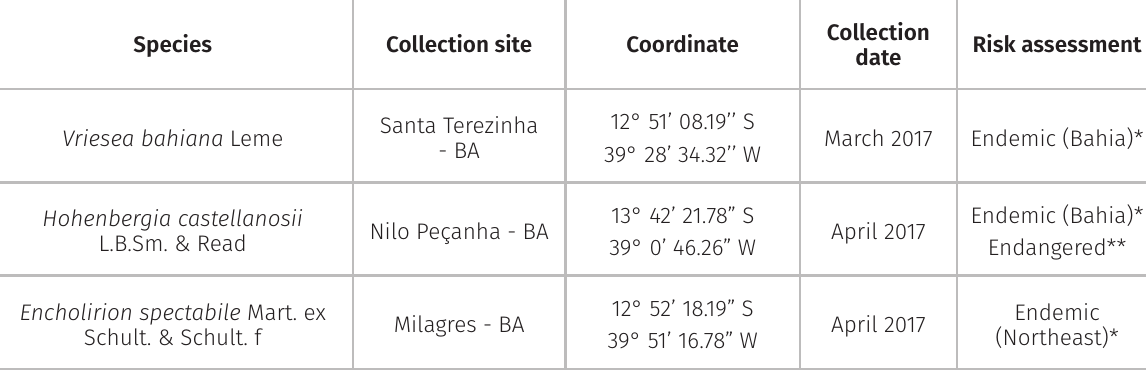
Table I. Information about collection sites and risk assessment of the species studied in this